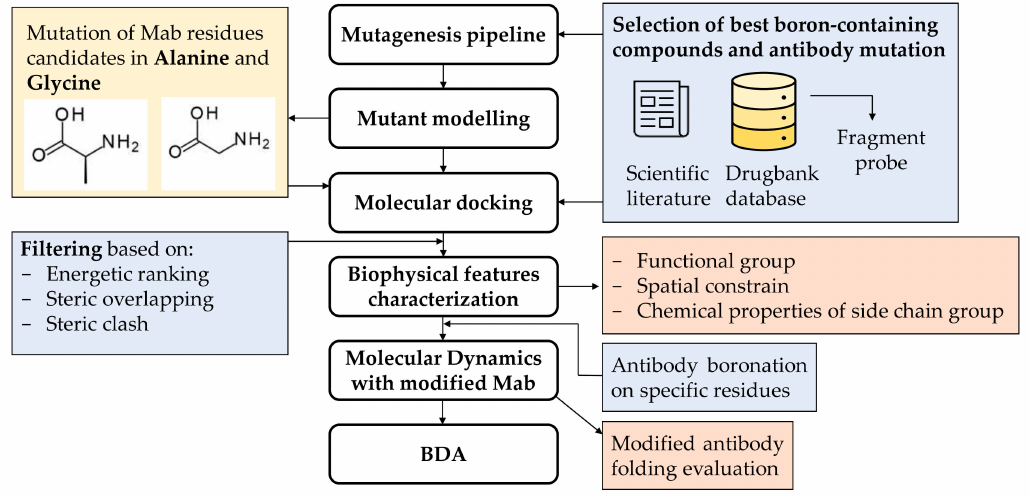
Figure 1. The BDA